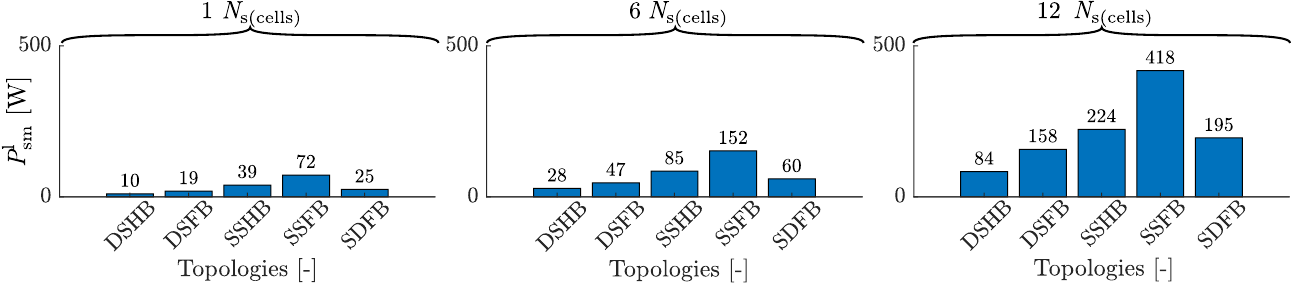
Figure 5. Total submodule losses for all the DC charging scenarios considering a maximum charging power of P c max for all topologies with 1, 6, and 12 N s(cells)